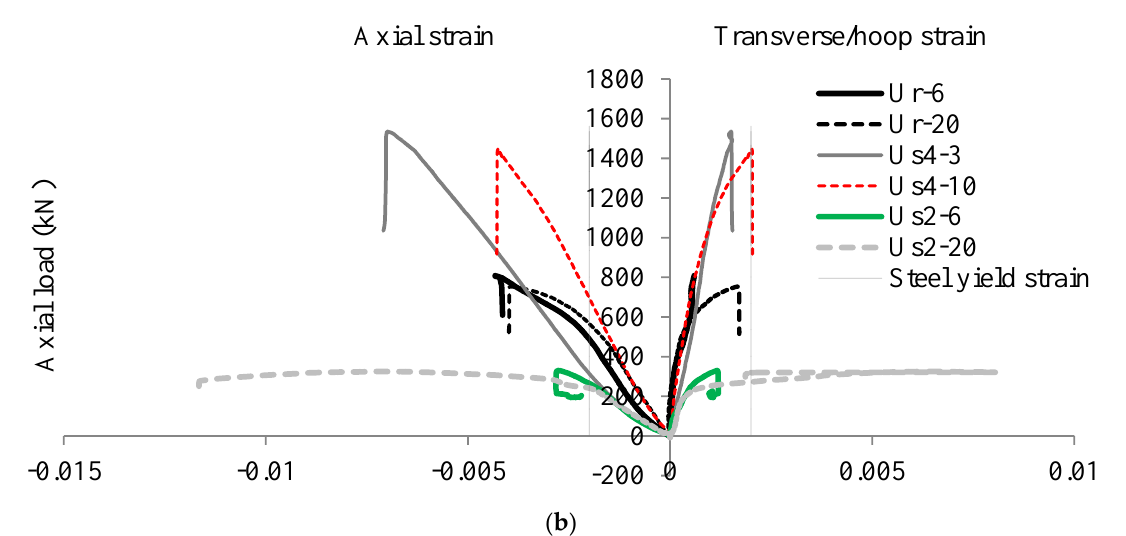
Figure 8. ( a ): Typical axial load-steel tube strain development in circular CFST columns. ( b ): Typical axial load-steel tube strain development in square/rectangular CFSTs. Table 2. Stress factors.